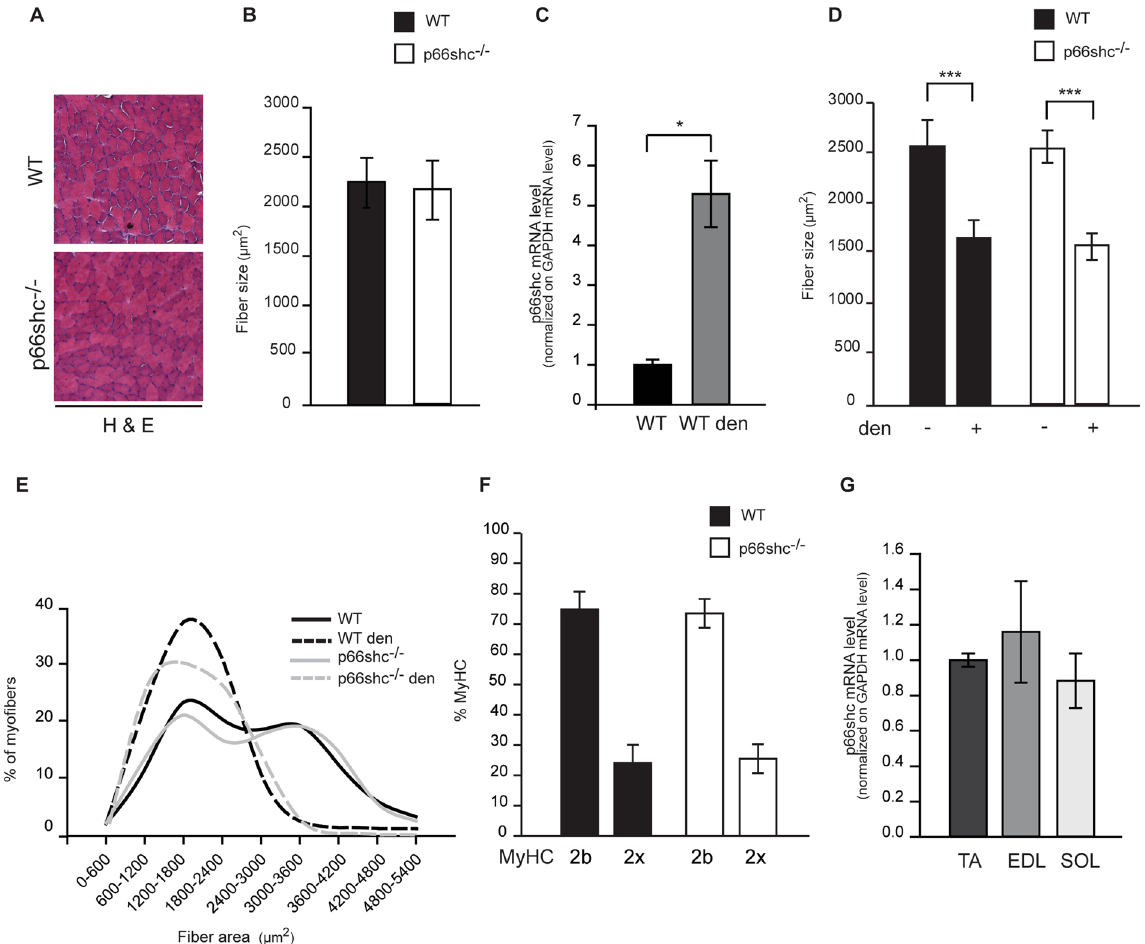
Figure 1. Skeletal muscle fiber size and myosin composition are unaffected by p66shc deletion. ( A ) Hematoxylin and Eosin (H&E) staining of transversal cryosections of wt and p66shc − / − TA muscles. ( B ) Mean fiber size of TA muscles of wt and p66shc − / − mice. Data are presented as mean ± SEM (3 animals per group). ( C ) mRNA expression levels of p66shc in wt and in denervated (den) TA muscles. GAPDH was used as control. * p < 0.05, t-test (Mann-Whitney rank sum test, two-tailed, unpaired) of 4 animals per condition. Data are presented as mean ± SEM ( D ) Mean fiber size of TA muscles of denervated (den) or not wt and p66shc − / − mice. *** p < 0.005, pairwise multiple comparison (Holm-Sidak method) of 3 animals per condition. Data are presented as mean ± SEM. ( E ) Fiber size distribution of TA muscles of wt and p66shc − / − mice. Data are presented as mean ± SEM (3 animals per group). ( F ) Quantitative myosin distribution analysis of wt and p66shc − / − muscle mice. Data are presented as mean ± SEM (3 animals per group). ( G ) mRNA expression levels of p66shc in TA, EDL and soleus (SOL) muscles. GAPDH was used as control. Data are presented as mean ± SEM (5 animals per